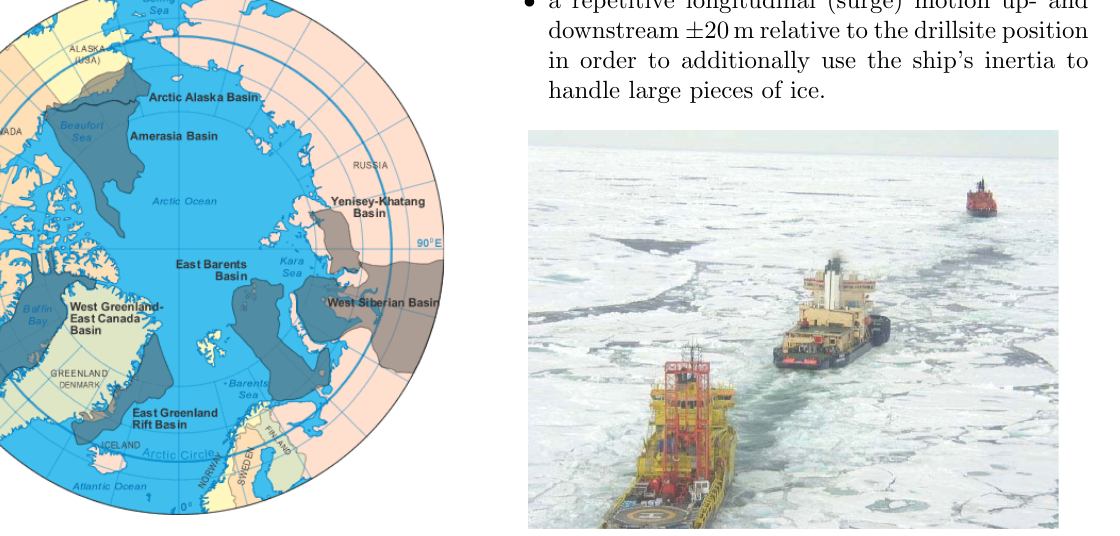
Figure 2: Arctic Coring Expedition (2004) with Vidar Viking, Oden, and Sovetskiy Soyuz from near to far. Courtesy: Moran et al.